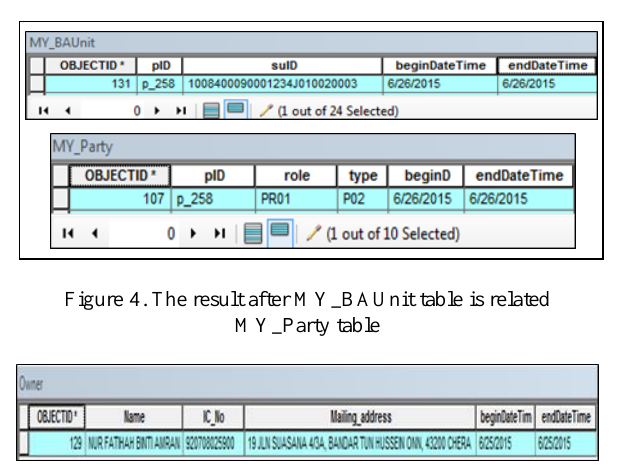
Figure 5. The result after MY_BAUnit table is related